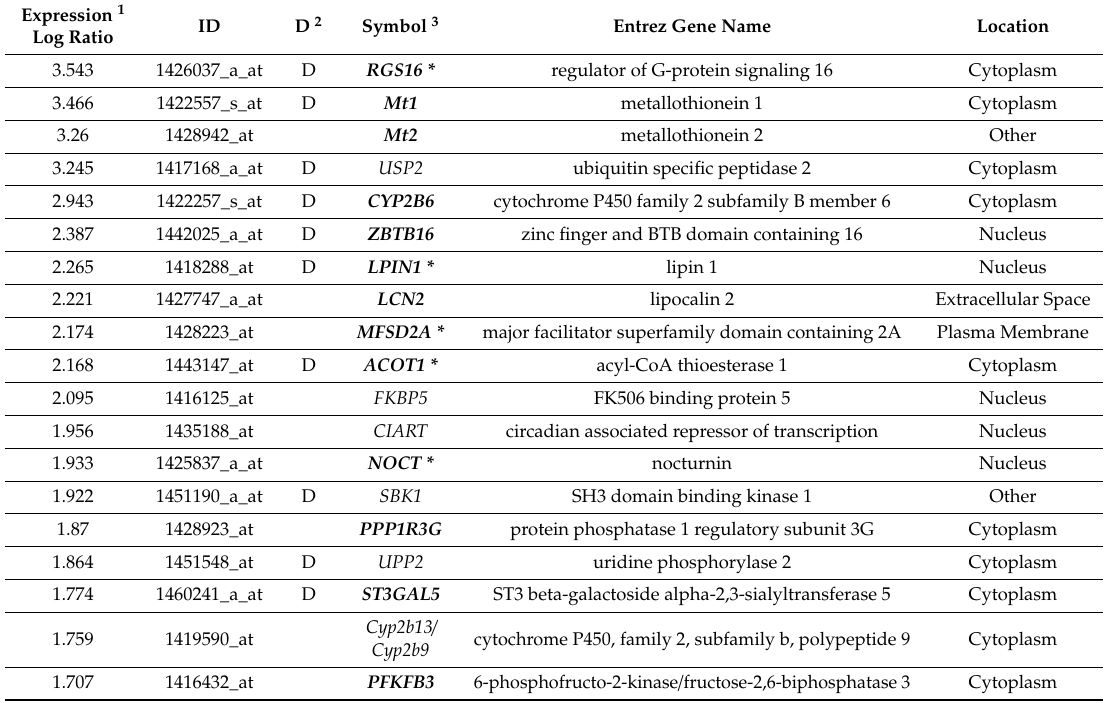
Table 1. List of di ff erentially expressed genes ( n = 153) identified in the liver of SHS-exposed mice, both before and after recovery time, relative to